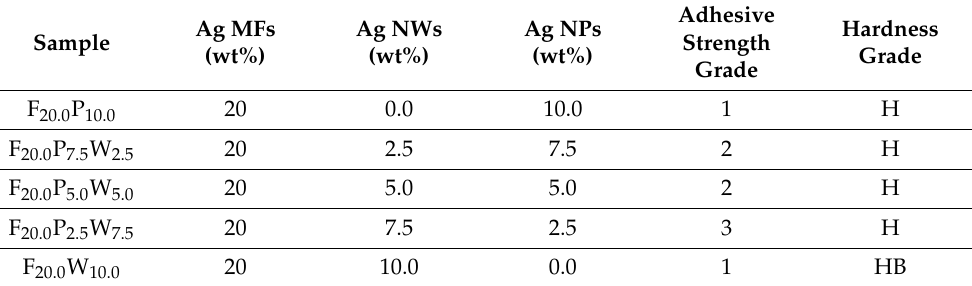
Table 4. Hardness and adhesive strength of silver paste paint films containing different amounts of Ag MFs, Ag NWs, and Ag NPs after curing at 60 ◦